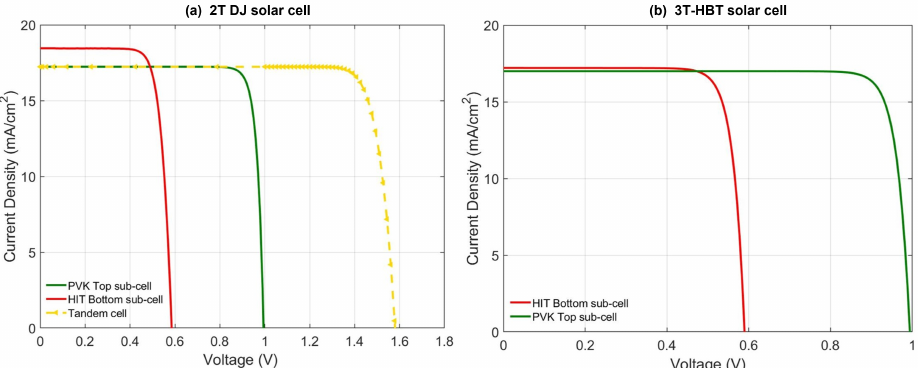
Figure 9. ( a ) J-V characteristics of the flat 2T PVK/Si DJ solar cell; ( b ) J-V characteristics of the flat 2T PVK/Si 3T-HBT solar